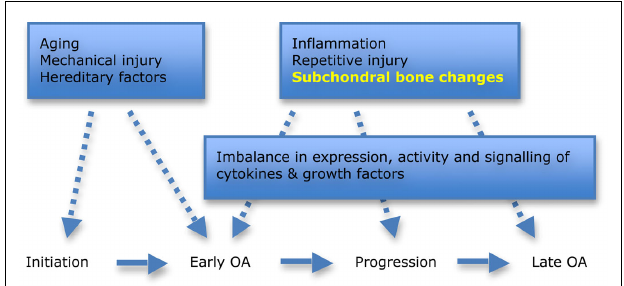
FIGURE 1 | Factors involved in the initiation and progression of hip osteoarthritis (OA). Aging, mechanical injury, and hereditary factors are all important when considering the role of morphology in disease initiation. Subchondral bone changes are now recognized as playing an important role in early disease and progression. Adapted from Goldring and Goldring